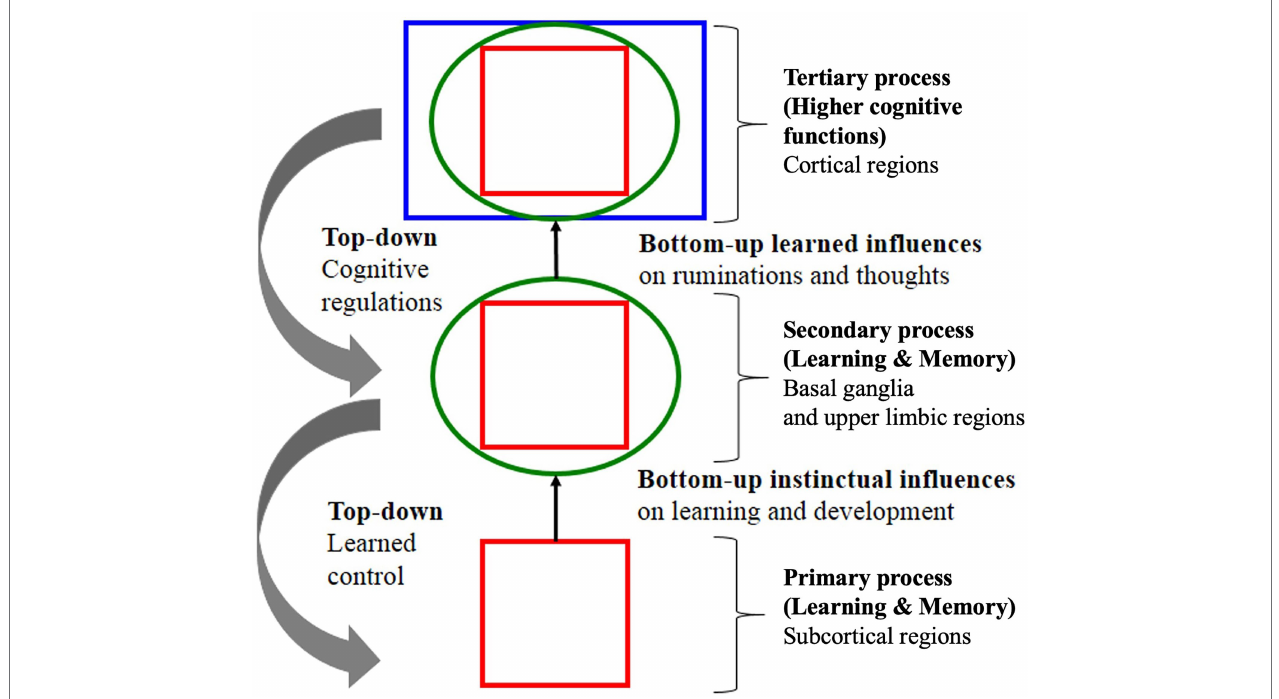
FIGURE 7 | Example of a theoretical signaling pathway showing hierarchical “top-down” self-regulation of emotions by cortical regulators . Note in this model, signaling is entirely internal and environmental signaling is not accounted for. Note also the deprecatory relationship between primary “bottom-up” “instinctual influences” ( lower brain function ) and secondary and tertiary processes of the cognitive system ( higher brain function ) adapted with permission from Panksepp and Solms